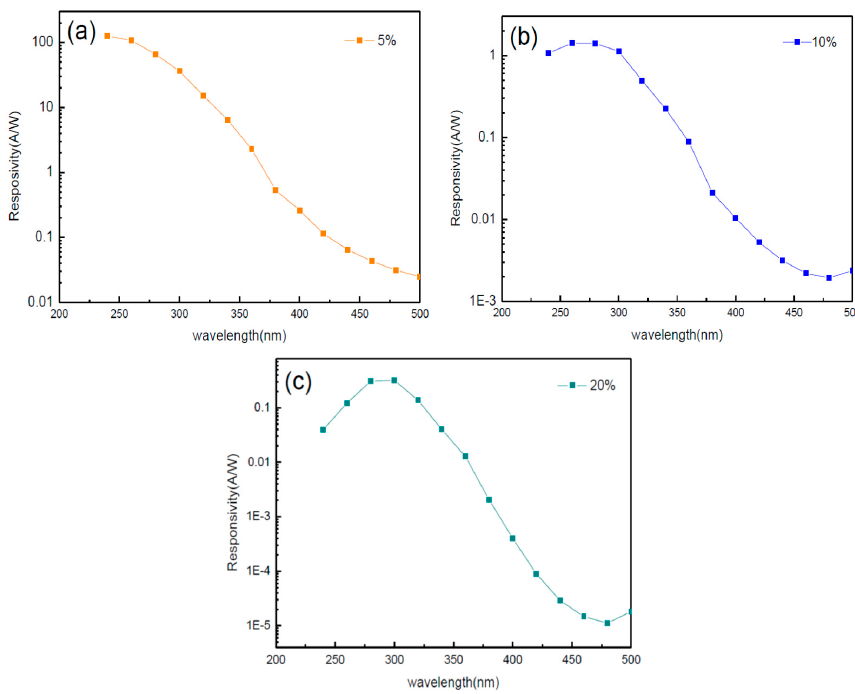
Figure 7. Responsivity of the devices with ( a ) 5%; ( b ) 10%; and ( c ) 20%.